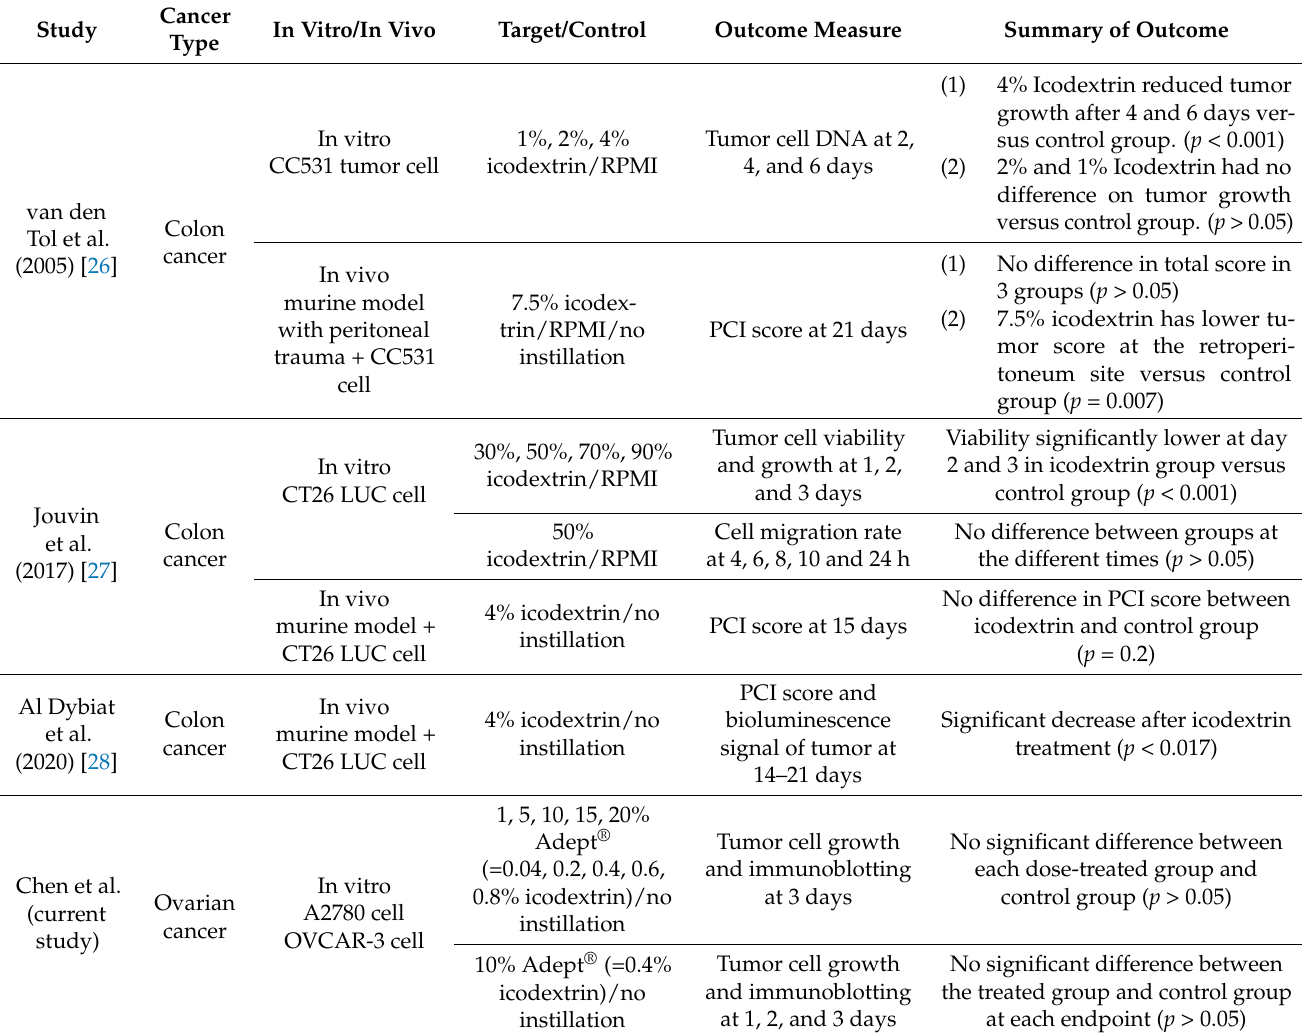
Table 3. Summary of published studies of the effectiveness of icodextrin solution on cancer cell pro-